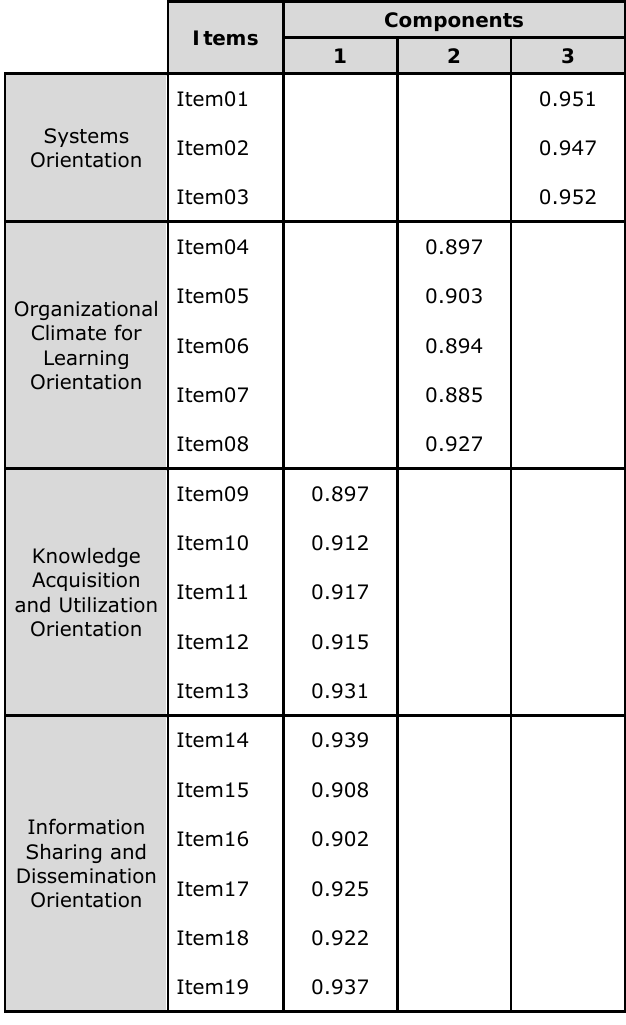
Table 2. “Factor Analysis (Rotated Component Matrix / Organizational Learning Culture)”. (Extraction Method: Principal Component Analysis. Rotation Method: Varimax with Kaiser Normalization. Rotation converged in 5